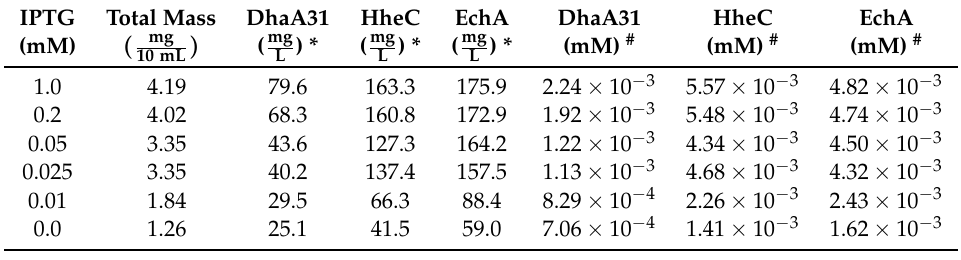
Table A3. Mass and molar concentration of enzymes in cell-free extract from Experiment 1.